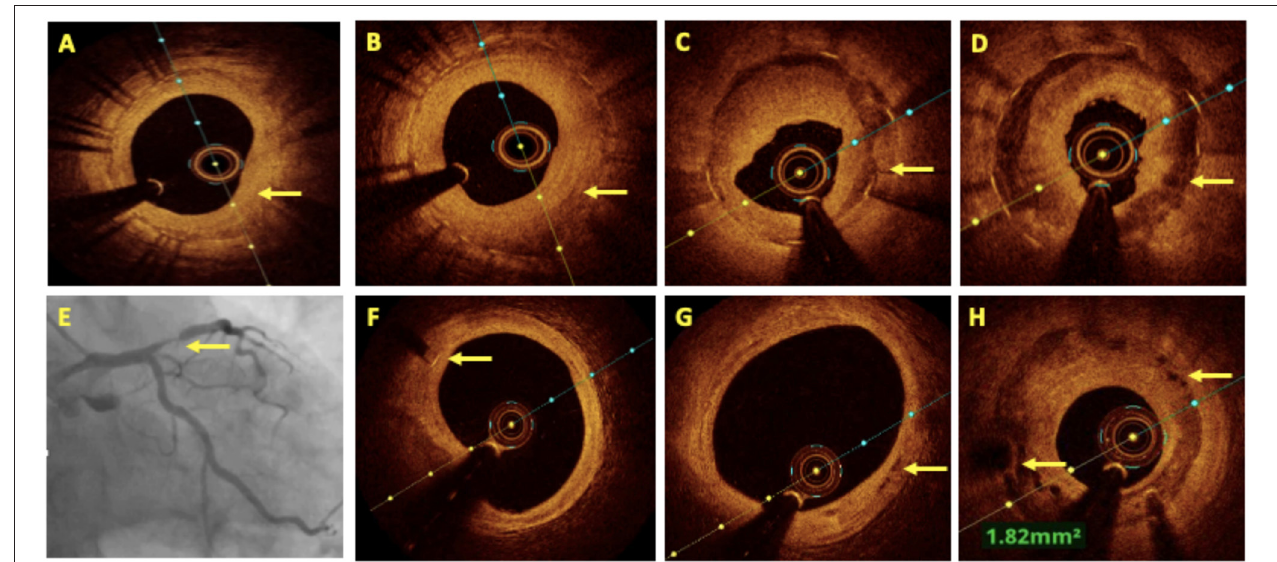
FIGURE 5 | OCT in in-stent restenosis (ISR). (A) Homogenous neointimal hyperplasia (NIH) in bare metal stent (BMS) restenosis. (B) Heterogenous NIH in a drug-eluting stent (DES) ISR. (C,D) Showed neoatherosclerosis as a cause of ISR in a well-expanded stent with well-demarcated calcium and fibrotic ingrowth. (E–H) Coronary angiography showing proximal LAD bioresorbable vascular scaffolds (BVS) ISR after 2 years of implantation. (F) The OCT image shows a distal marker of BVS, (G) almost completely absorbed BVS struts in the middle and distal part of the stent, and (H) BVS ISR at the proximal segment with peri-strut low intensity